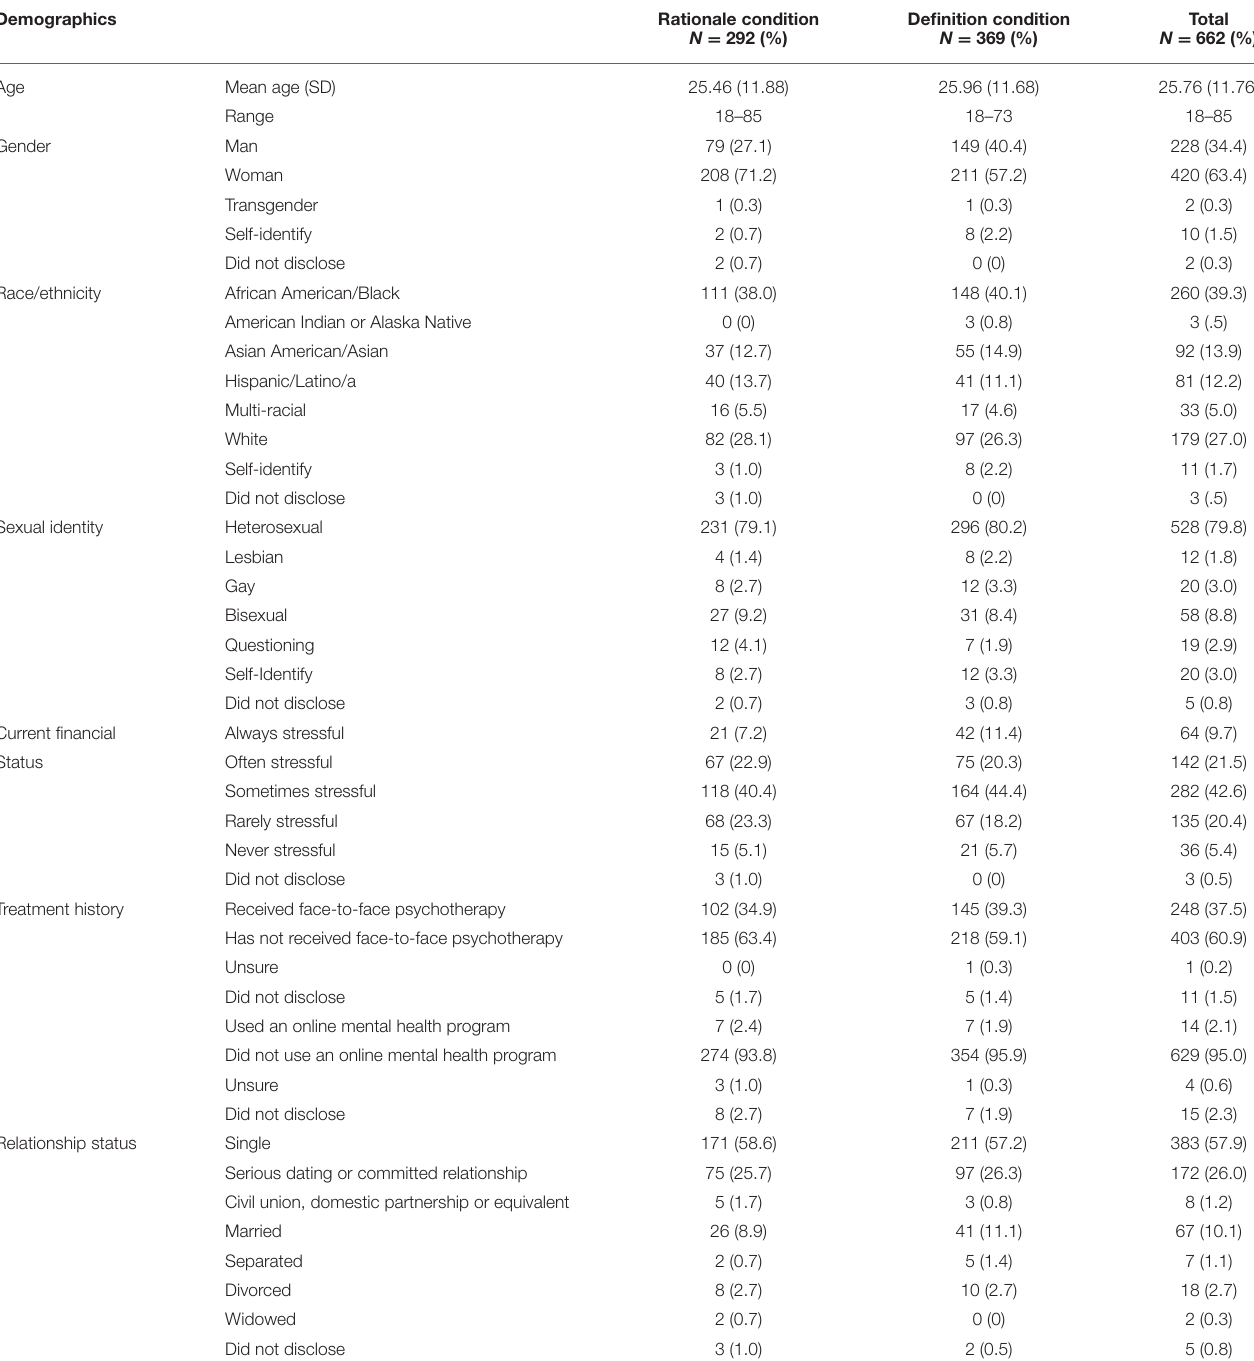
TABLE 1 | Participant